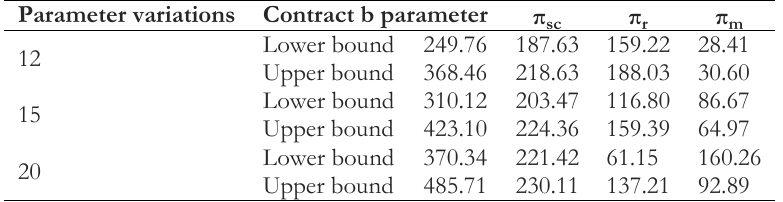
Table 11. The trend of variations in firms' profits due to variations in wholesale prices post-contract.